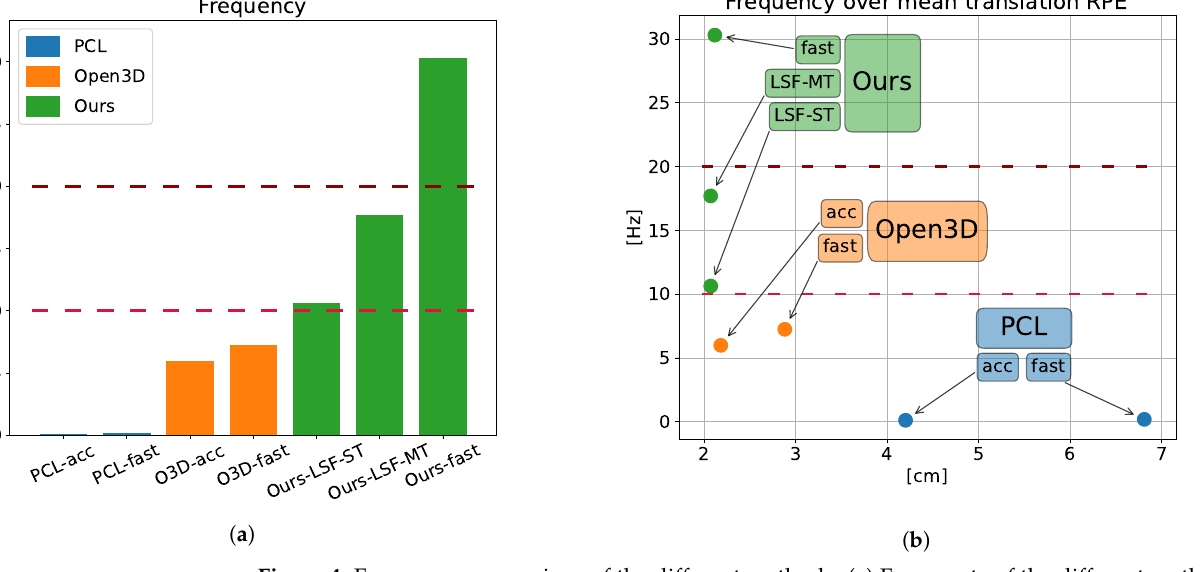
Figure 4. Frequency comparison of the different methods. ( a ) Frame rate of the different methods. The usual working frequencies of 3D lidar, 10 and 20 Hz, are displayed along the data. ( b ) Frequency of the different methods over the translational RPE. The usual working frequencies of 3D lidar, 10 and 20 Hz, are displayed along the data. Table 1. Computation time breakdown of the proposed method.